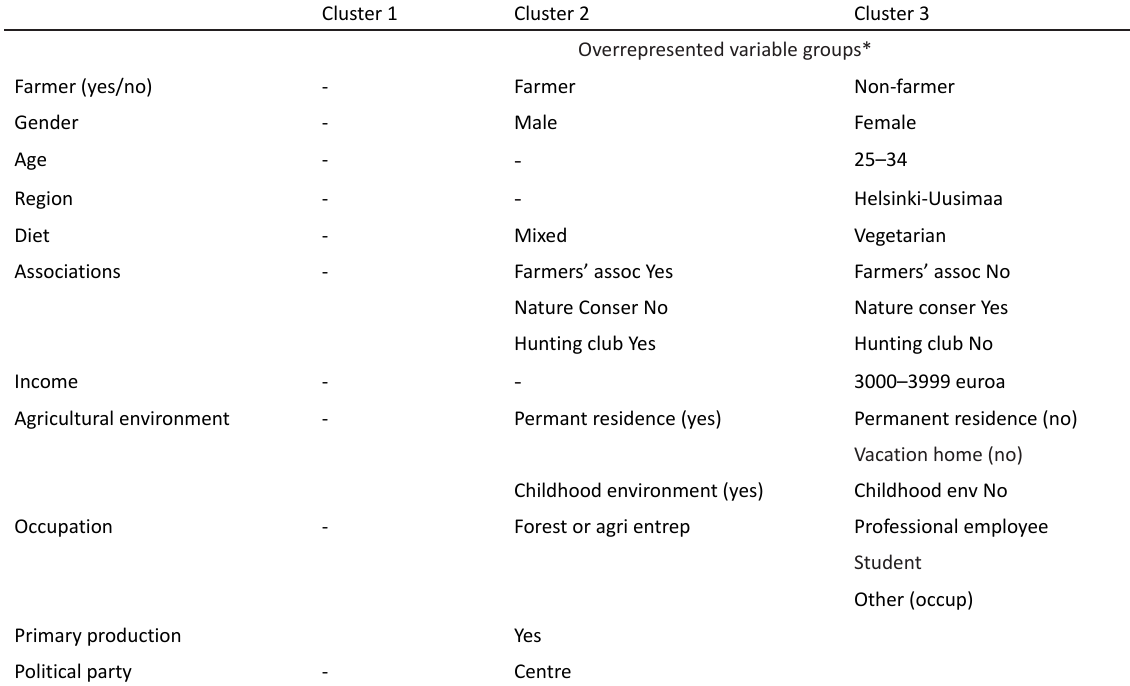
Table 6. The over-represented variable groups for each cluster. The full documentation of the comparison between clusters in Appendix